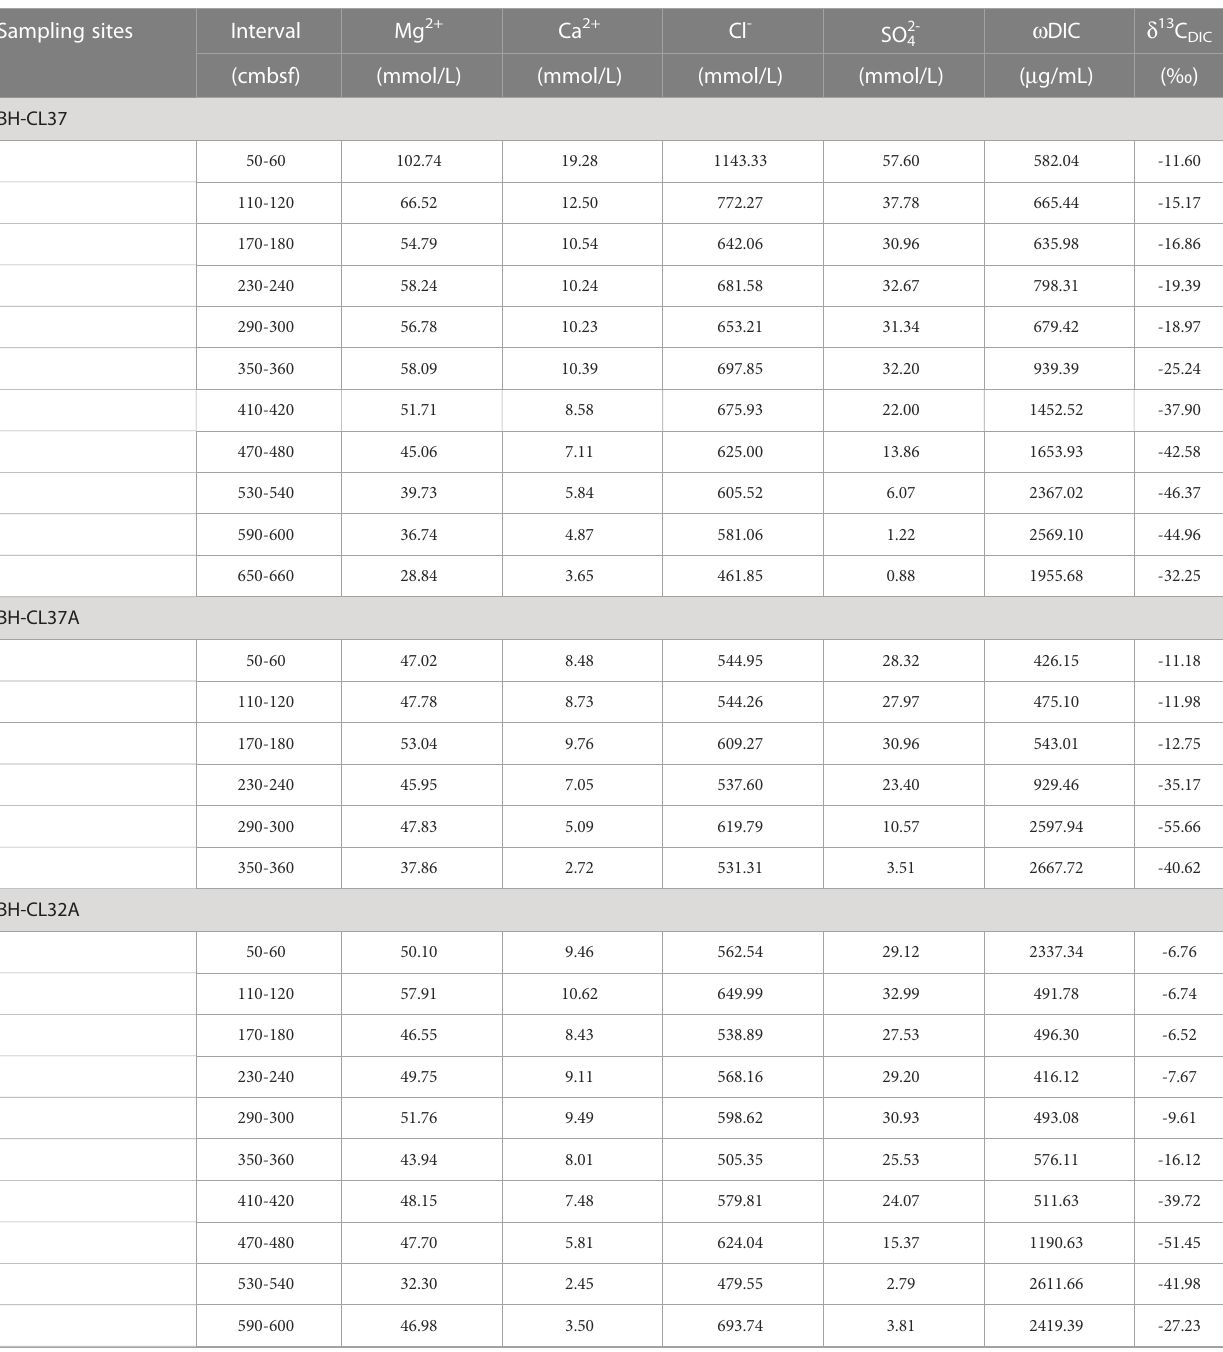
TABLE 2 Concentration of main ions, DIC and d 13 C DIC in pore water. Sampling